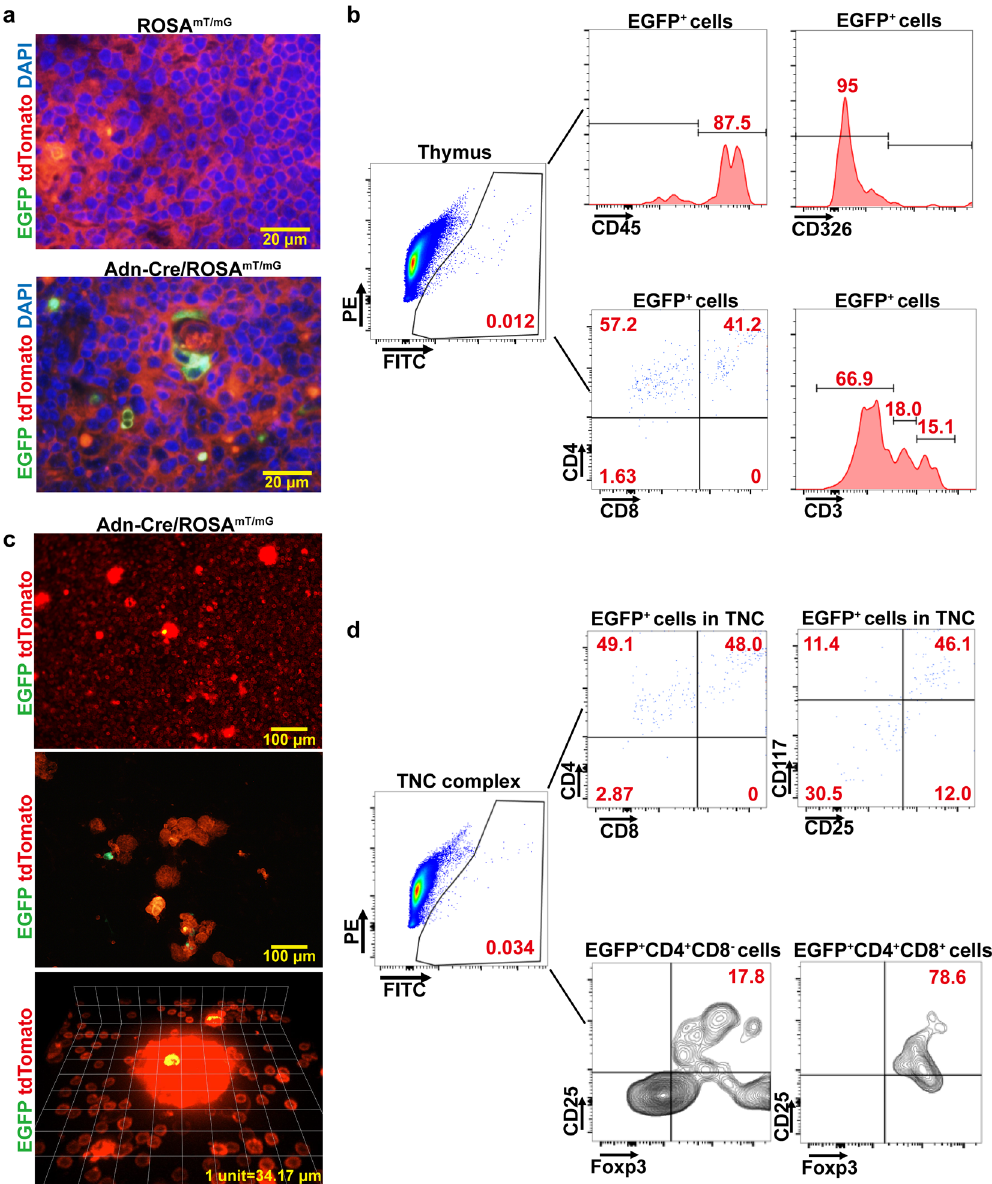
Fig. 2 Flow cytometric analyses of adiponectin-expressing thymocytes. a Tissue cryosections were prepared from thymus of ROSA mT/mG and Adn-Cre/ ROSA mT/mG mice to visualize the EGFP + cells exhibiting bright green fl uorescence. b Single-cell suspensions were prepared from the thymus of Adn-Cre/ ROSA mT/mG mice. Flow cytometry was performed to analyze EGFP + cells and their surface expression of markers including CD45, CD326, CD4, CD8, and CD3. c Cell suspensions were prepared from the thymus of Adn-Cre/ROSA mT/mG mice ( top ). TNC complexes were then enriched by sedimentation in FBS ( middle ). The EGFP + cells were visualized by real-time live confocal microscopy ( bottom ) [more details in Supplementary Movie 1]. d Flow cytometry